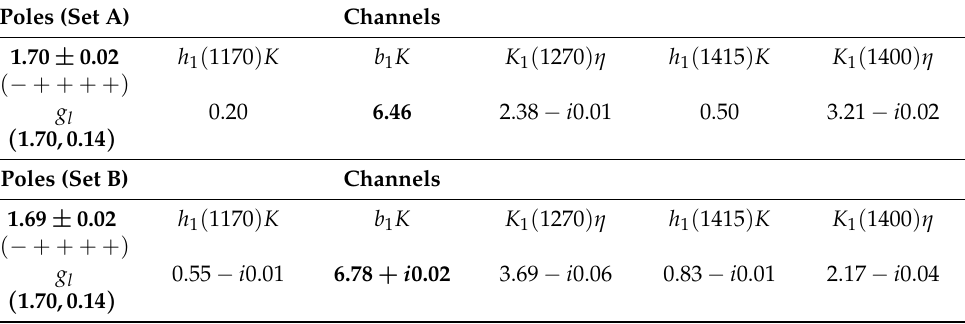
Table 13. Poles and their corresponding couplings to the channels contributing to the PA interaction with J P = 1 − . Here the flavor-neutral axial mesons have J PC = 1 + − . The dominantly coupled channel is emphasized in boldface for each pole. The errors of the poles are from varying the subtraction constant within α ( µ = 1GeV ) = 1.35 0.17, and only the central values of the couplings are given. − ± The last row of each panel gives the central values of the peak mass and width ( M peak , Γ peak ) for the corresponding pole after considering the axial-vector meson